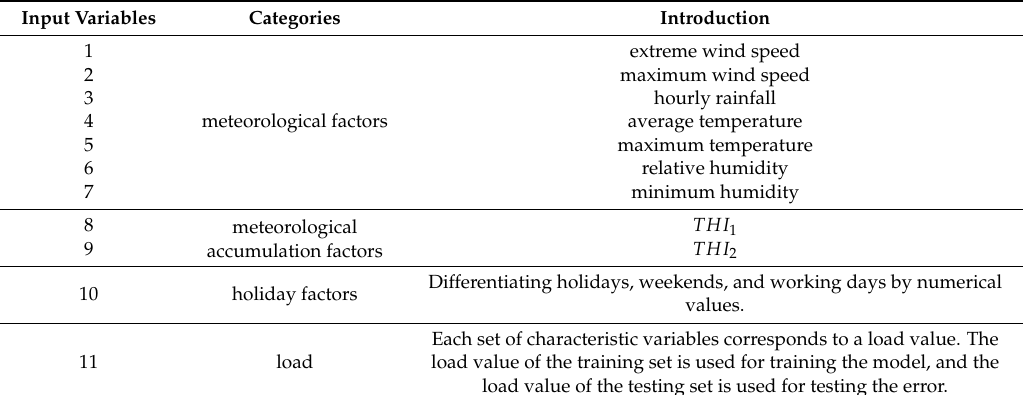
Table 1. Categories of input variables